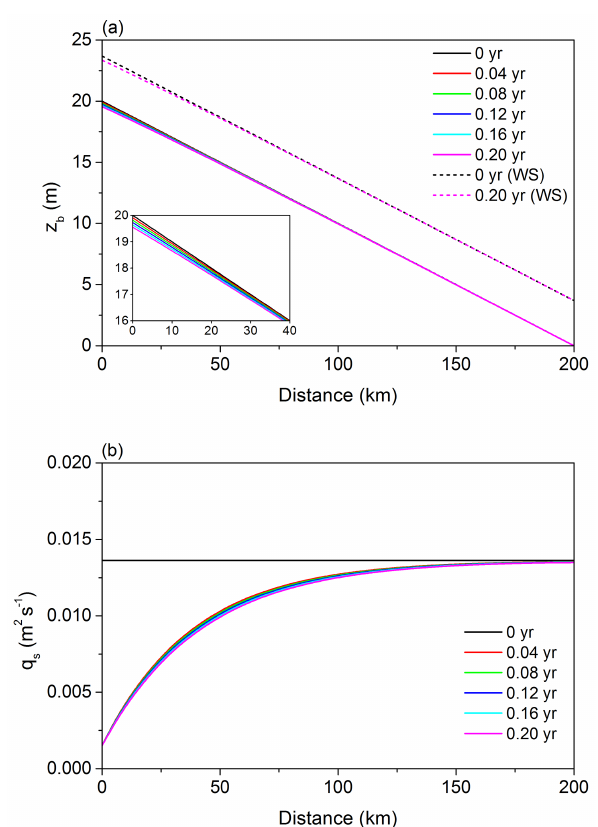
Figure 5. The 0.2-year results for the case of uniform sediment using the entrainment form of the Exner equation: time variation of (a) bed elevation z b and water surface (WS), (b) sediment load per unit width q s of the LYR in response to the cutoff of sediment supply. Sediment fall velocity v s is arbitrarily multiplied by a factor of 0.05 while holding bed grain size constant in this run. The inset shows detailed results near the upstream